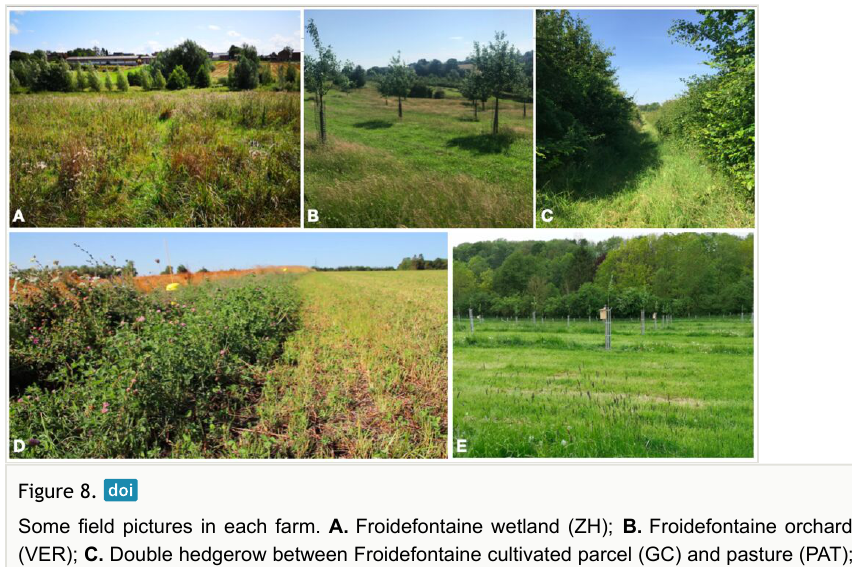
Some field pictures in each farm. A. Froidefontaine wetland (ZH); B. Froidefontaine orchard (VER); C. Double hedgerow between Froidefontaine cultivated parcel (GC) and pasture (PAT); D. Emeville flower strip between FRE and EPI parcels (photo credit : I. Van Dorpe); E. Emeville orchard